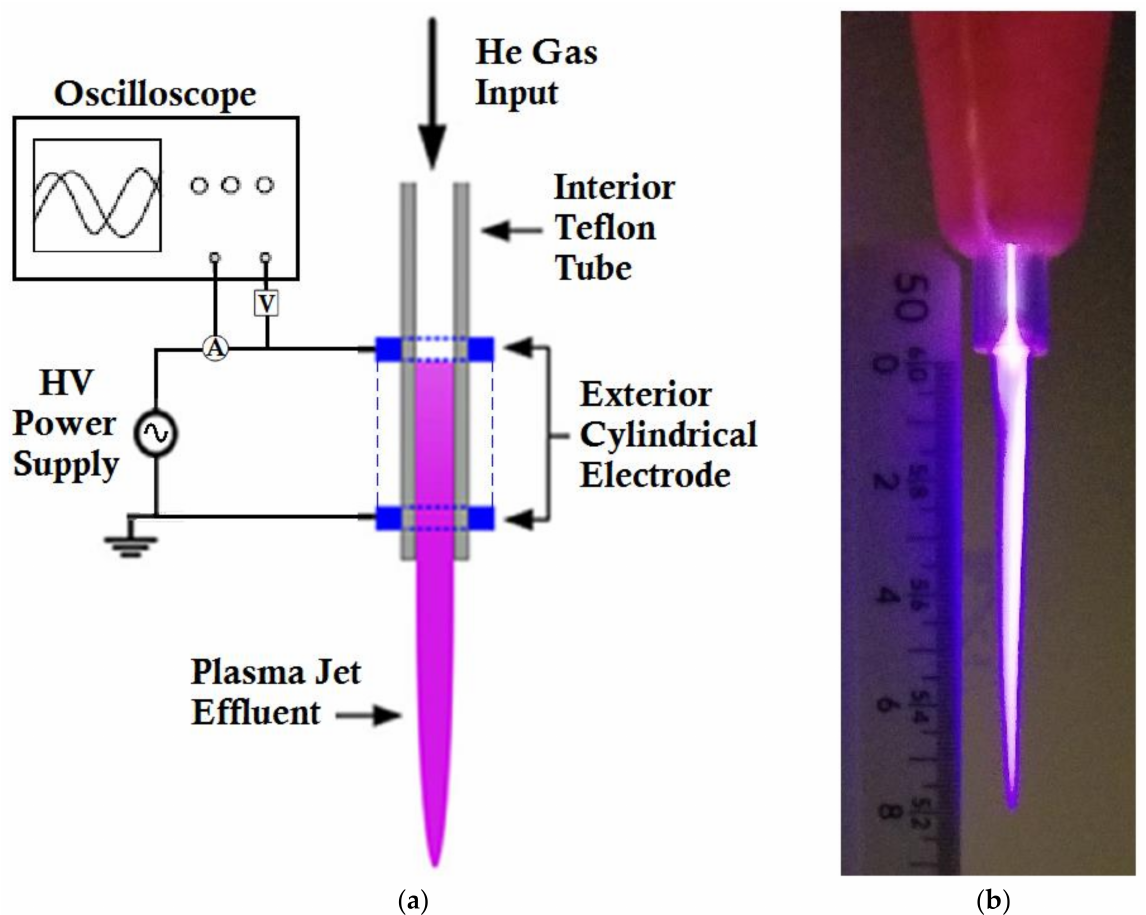
Figure 2. ( a ) Schematic of the experimental setup used to generate and monitor the continuous operation of the cold plasma jet in atmospheric air. ( b ) Measurement picture of side-by-side comparison of a centimeter (cm) ruler to the cold plasma jet effluent used to treat the polymer